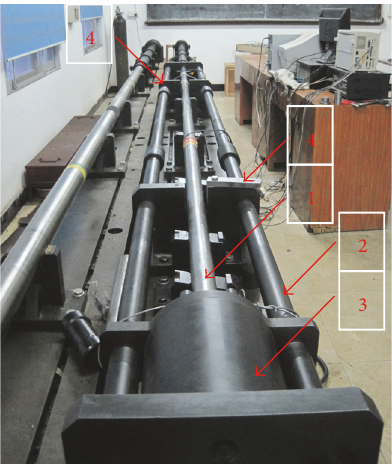
Figure 3: The sketch of the experiment devices (1, stress transfer device, 2, axial compression load outreach framework, 3, axial compression loading device, and 4, bearing of the axial compression loading outreach framework).